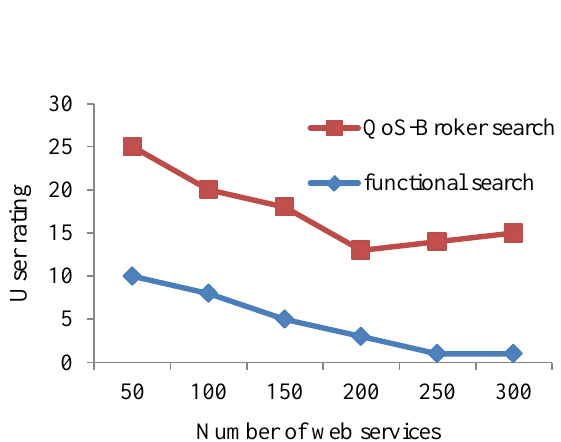
Figure 7. Comparison of user reviews with & Without QoS Broker based